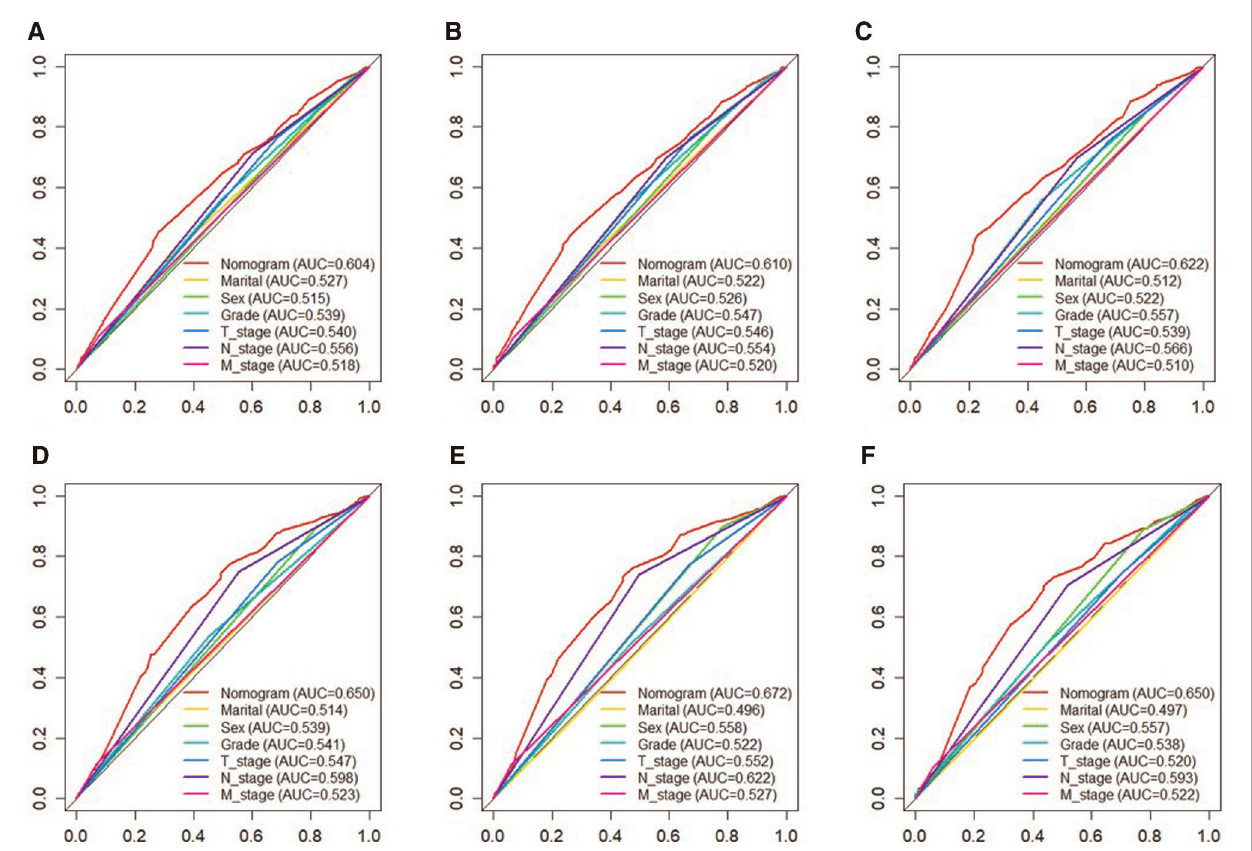
FIGURE 4 | The ROC curves of nomogram and all independent predictors at 36- ( A ), 60- ( B ), and 84 months ( C ) in the training cohort and at 36- ( D ), 60- ( E ), and 84 months ( F ) in the validation cohort. ROC, receiver operating